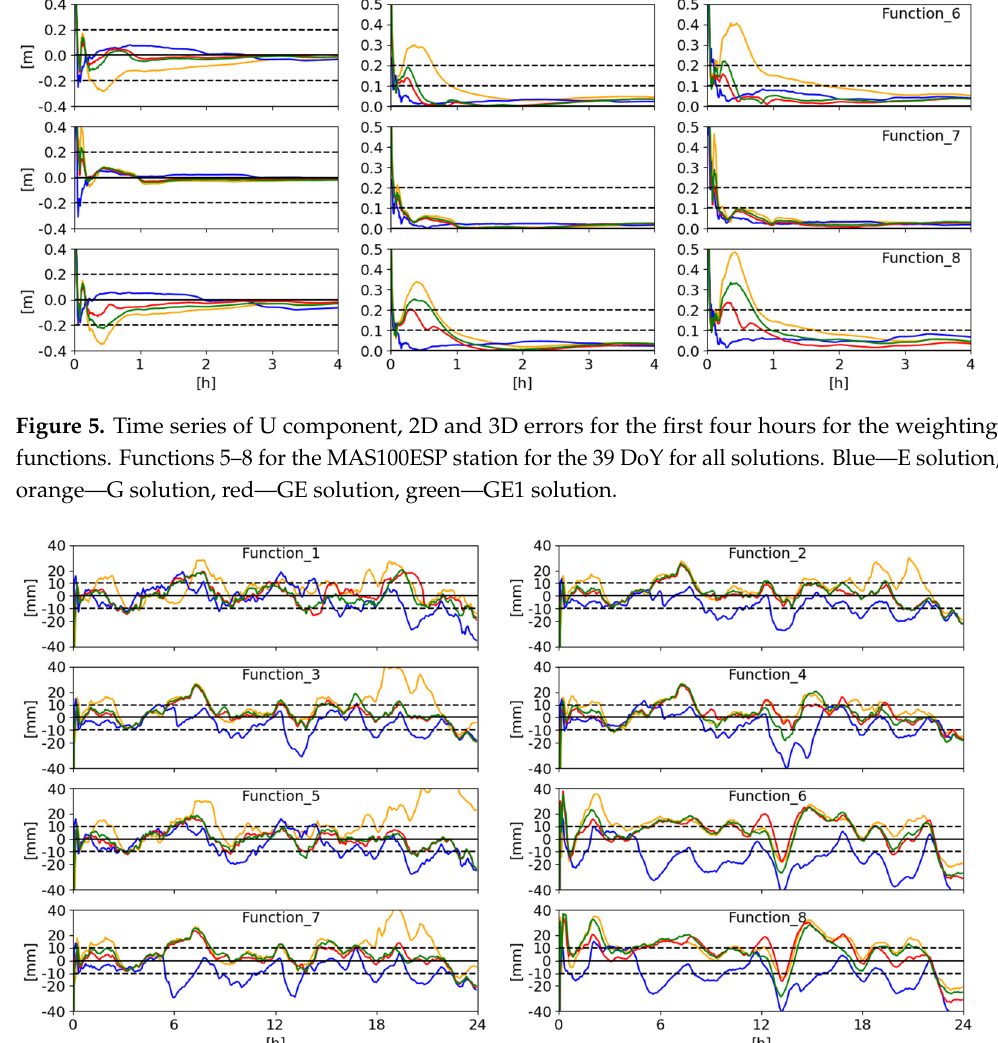
Figure 6. Time series of ZPD differences between the estimated value from PPP and calculated by the IGS for the MAS100ESP station for the 39 DoY for all solutions and weighting functions. Blue − E solution, orange − G solution, red − GE solution, green − GE1 solution.